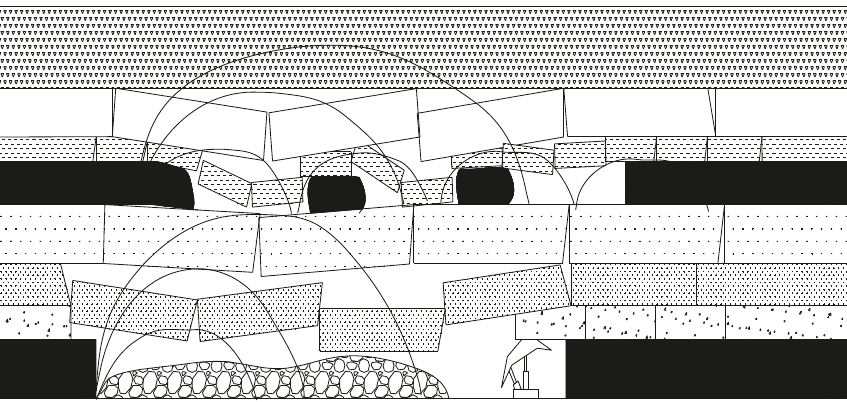
Figure 6: Mechanical model of the loose layer arch